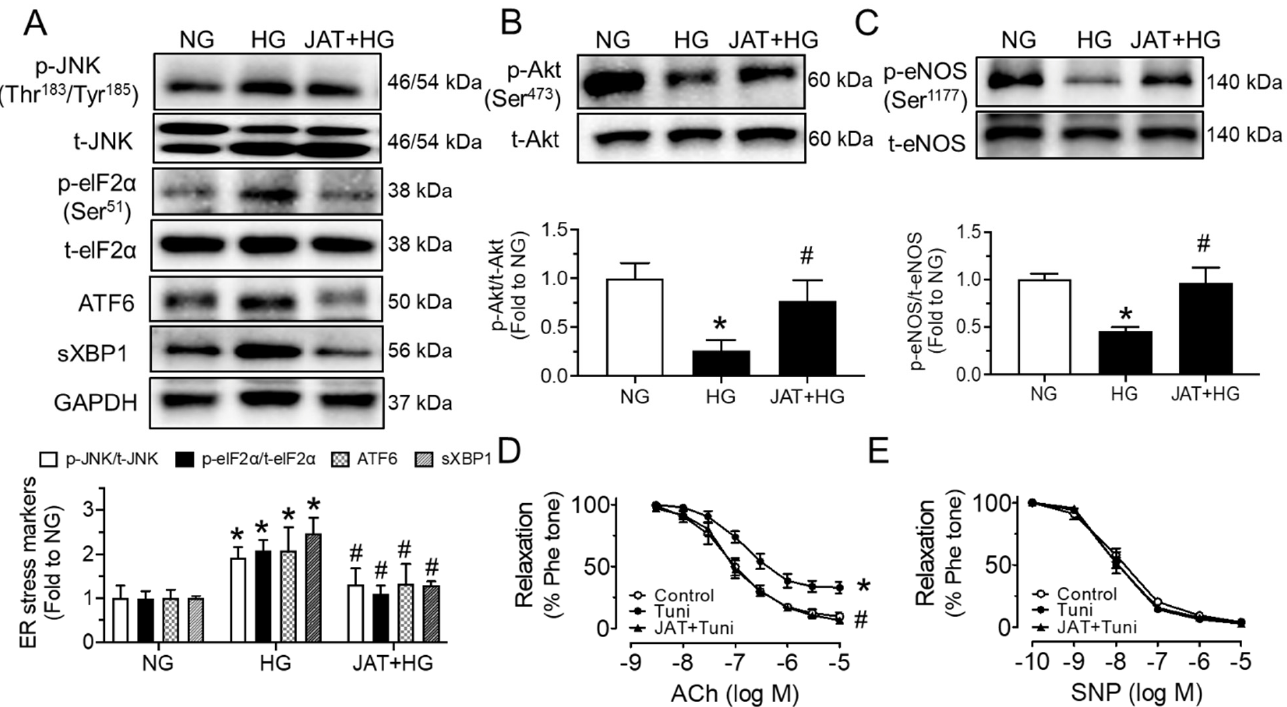
Figure 3. Jatrorrhizine attenuates endoplasmic reticulum (ER) stress and stimulates Akt/eNOS pathway in mouse aortas in hyperglycemic conditions ex vivo. ( A – C ) Western blotting data showing the expressions of ER stress markers, including phosphorylation and total JNK and elF2 α , cleaved ATF6 and spliced XBP1; phosphorylation of eNOS at Ser 1177 and total eNOS; and phosphorylation of Akt at Ser 473 and total Akt in mouse aortas treated with HG (30 mM) and JAT (1 µ M) for 48 h ex vivo. ( D , E ) JAT (1 µ M) improved ACh-induced EDRs in mouse aortas treated with ER stress inducer tunicamycin (Tuni; 2 µ g/mL, 24 h) ex vivo; with no effect on SNP-induced relaxations. Results are mean ± SEM of 4–5 experiments. * p < 0.05 vs. NG or Control; # p < 0.05 vs. HG or Tuni. In line with the results in high-glucose-stimulated aortas, JAT (1 µ M, 24 h) was found to effectively inhibit ER stress and the enhance Akt/eNOS pathway in the aortas of high- fat diet (45% kcal% fat)/streptozotocin-induced mice ex vivo (Figure 4A–C). Moreover, phosphorylation of Akt and eNOS was reduced, while ER stress markers were increased upon high-glucose exposure (30 mM, 48 h) in human umbilical cord vein endothelial cells (HUVECs) compared with protein levels in the control group (mannitol added as osmotic control). These changes were prevented by JAT at 1 µ M for 48 h (Figure